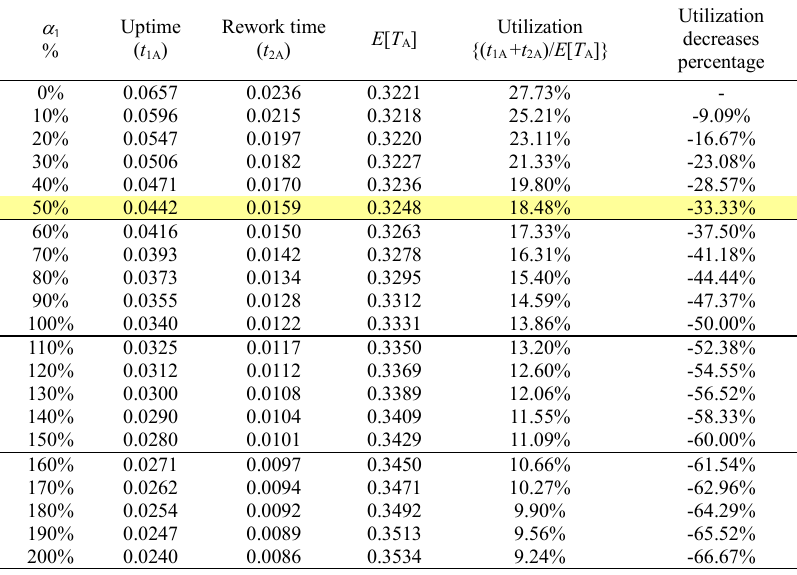
Table 1. Variations of fabrication rate increase percentage ( α 1 ) effects on uptime, rework time, cycle